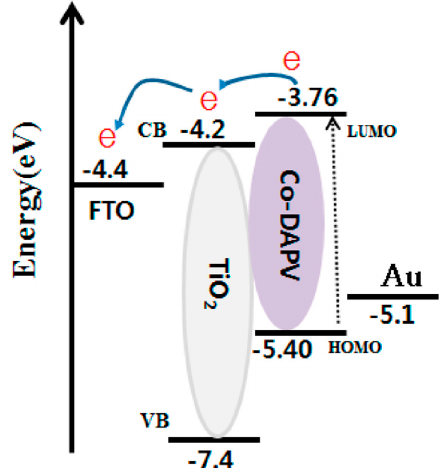
Figure 7. Energy level diagram showing the band edge alignment at TiO2-DAPV heterojunction, showing favorable energy cascade for unidirectional charge transfer. Reproduced with permission from [147] .